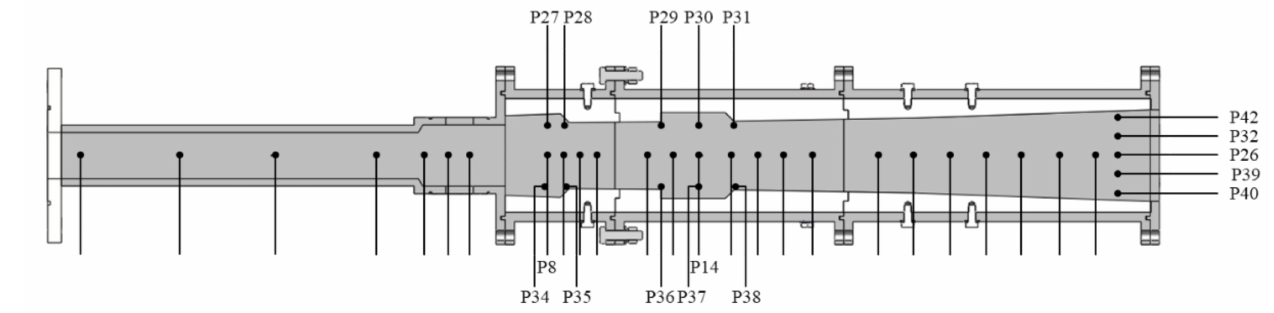
Figure 11. Distribution and naming of pressure taps along the tested SSRJ.